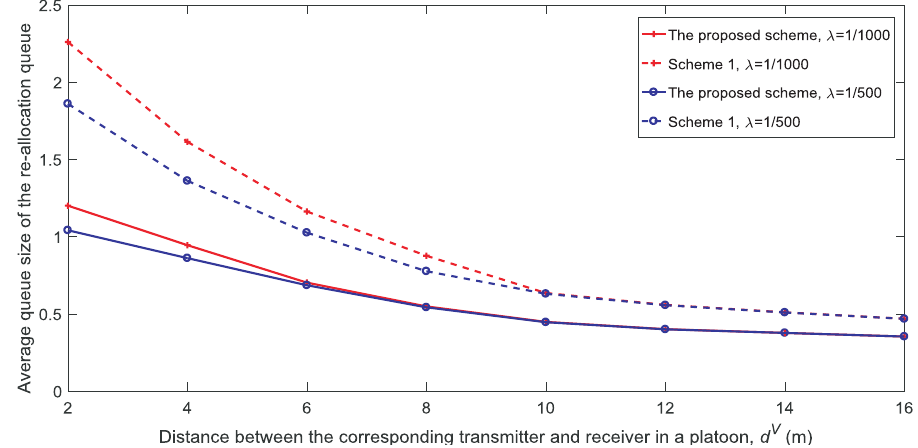
Figure 13. Average queue size of the re-allocation for different distances between the corresponding transmitter and receiver in a platoon d V ( K = 3, V = 10, N = 5 )